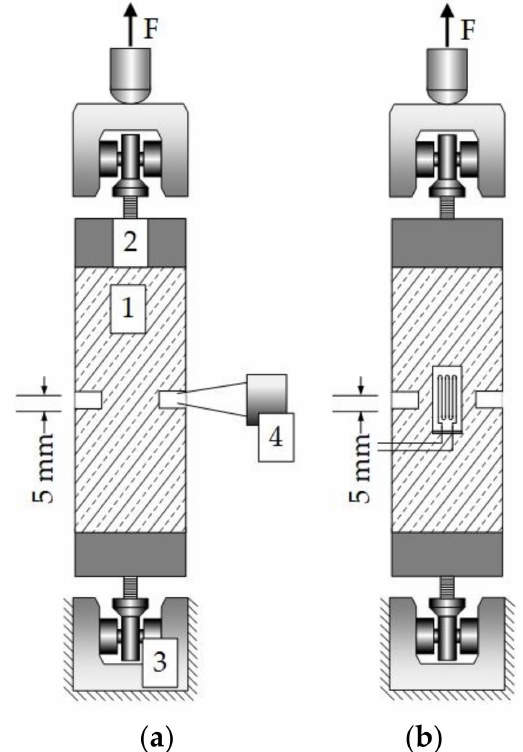
Figure 2. Test setups: ( a ) static tensile test setup including the specimen 1, the two adhered test stamps (bottom/top) 2, the lower/upper clamping in the machine 3, and the clip-on-gage 4; ( b ) cyclic tensile test setup with strain gauges.